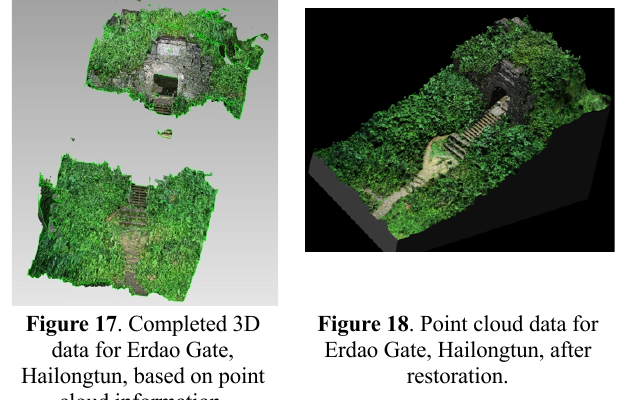
Figure 11 . 3D digital model of Feifeng Gate.